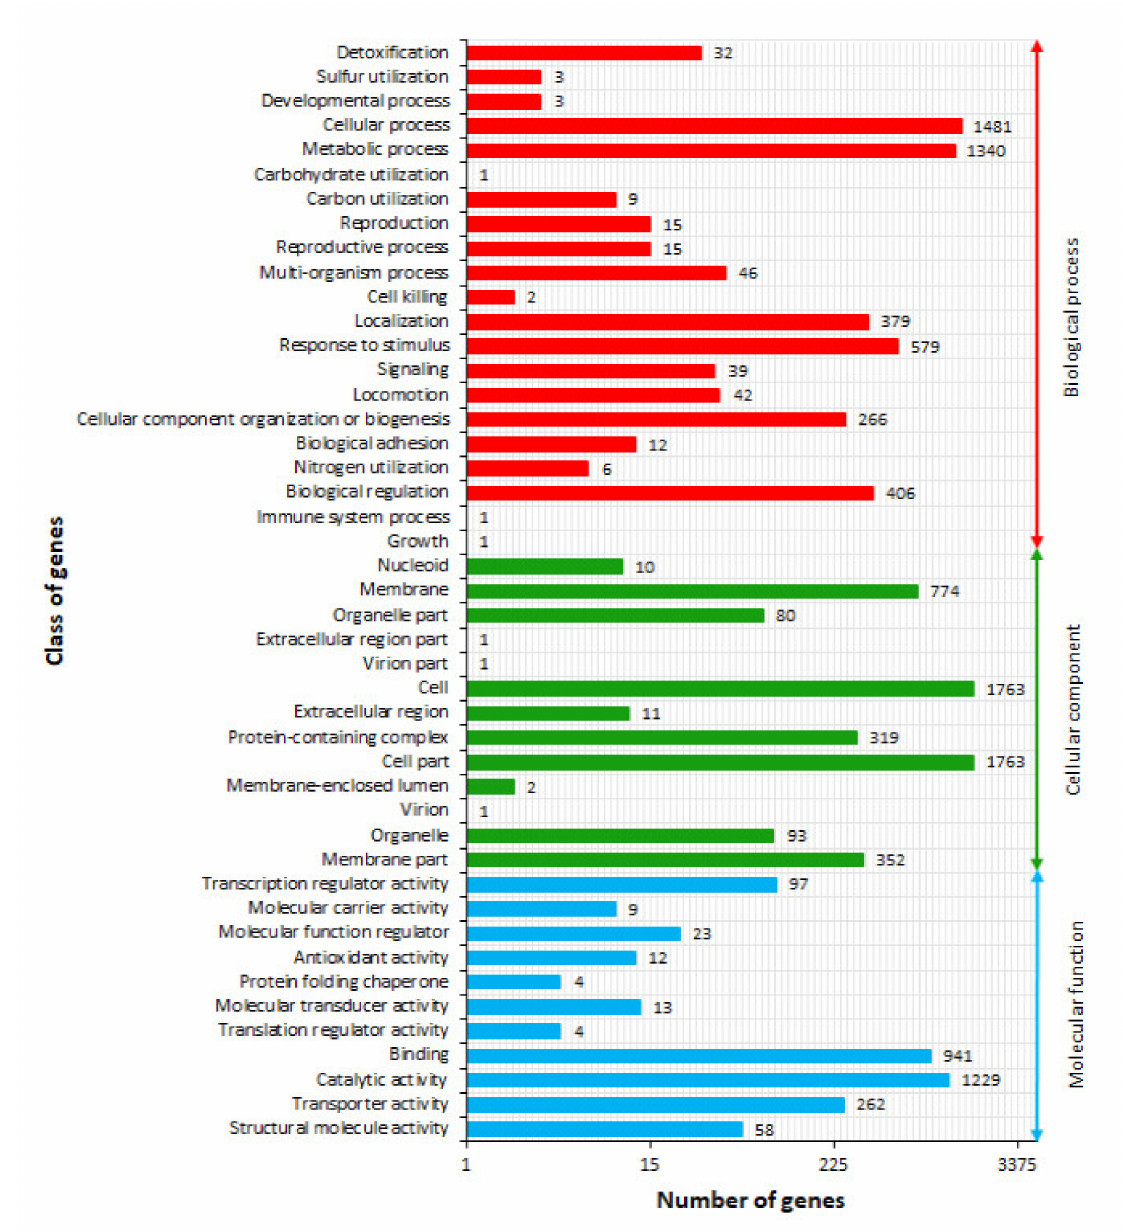
Figure 4. Classification of Gene Ontology (GO) functional annotation of Enterobacter sp. LU1. Colored bars indicate numbers of genes assigned to COG